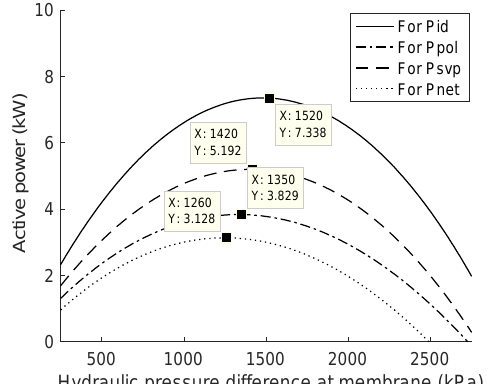
Fig. 6. Active power P as function of hydraulic pressure ΔP h .